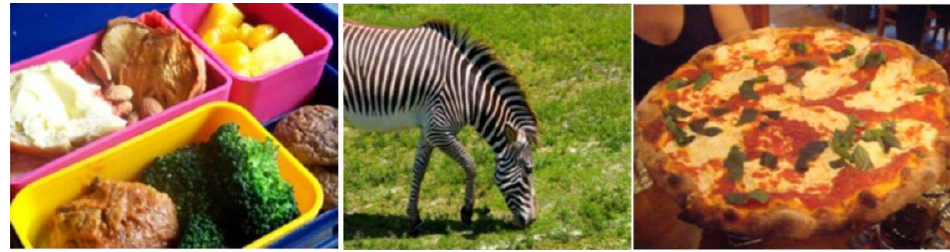
Figure 7. Images from COCO dataset.